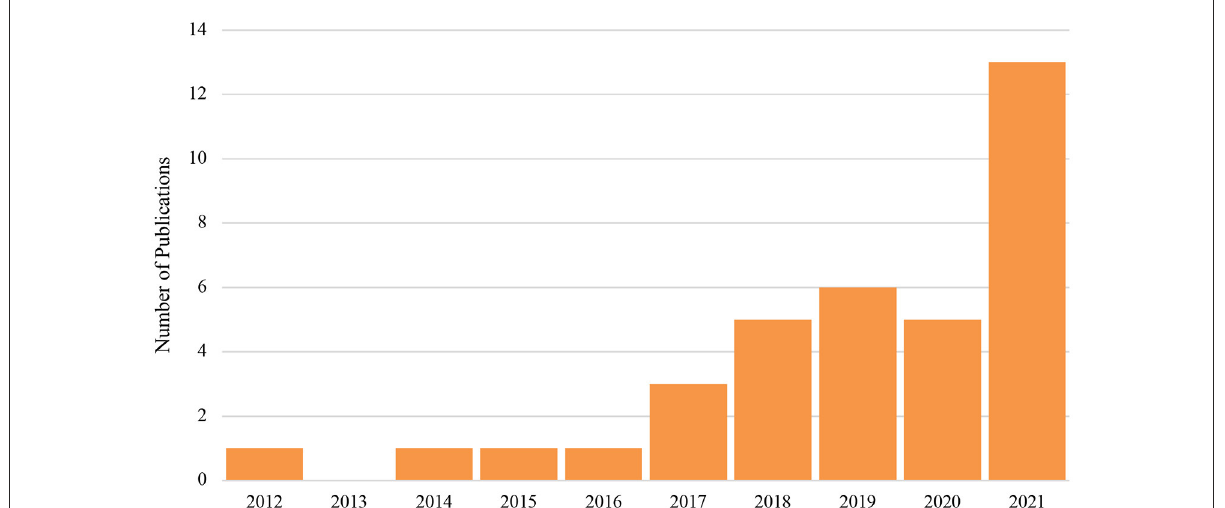
FIGURE1 Number of publications on enhanced weathering (the application of silicate rock to soils) as a method for carbon dioxide removal in terrestrial ecosystems. Publications were generated using the search “enhanced weathering” AND “carbon” AND “soil” and then further refined to meet search criteria (see methods in section Literature survey of enhanced weathering study methodology and context).